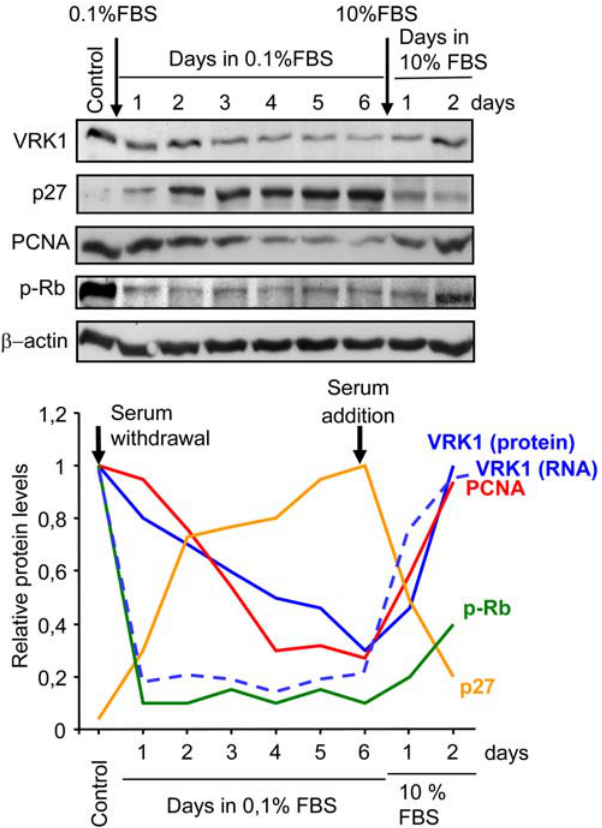
Figure 4. Time course of changes in cell cycle related proteins level after serum withdrawal and serum readdition to WS1 cells. The proteins were determined in an immunoblot with specific antibodies for each protein, VRK1, p27, PCNA and phospho-Rb. The level of actin was used as a loading control. At the bottom is shown the quantification of the level of each protein. In the case of VRK1 it is also shown the quantification by RT-PCR of its RNA (dashed line) at the same time points. These experiments were independently performed three times.